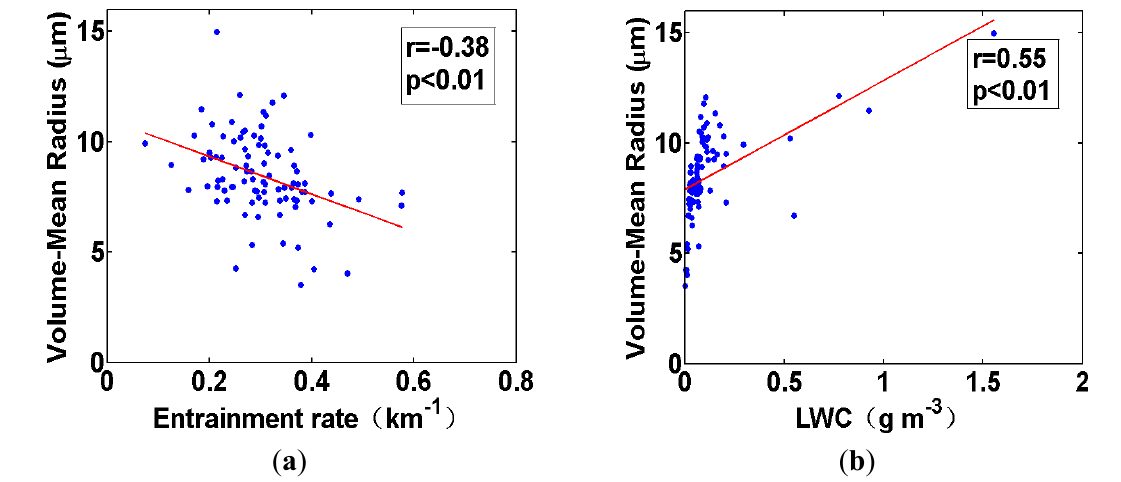
Figure 5. Scatter plots of ( a ) volume-mean radius of cloud droplets vs. entrainment rate and ( b ) volume-mean radius vs. liquid water content. Each legend provides the correlation coefficient ( r ) and the p value of the